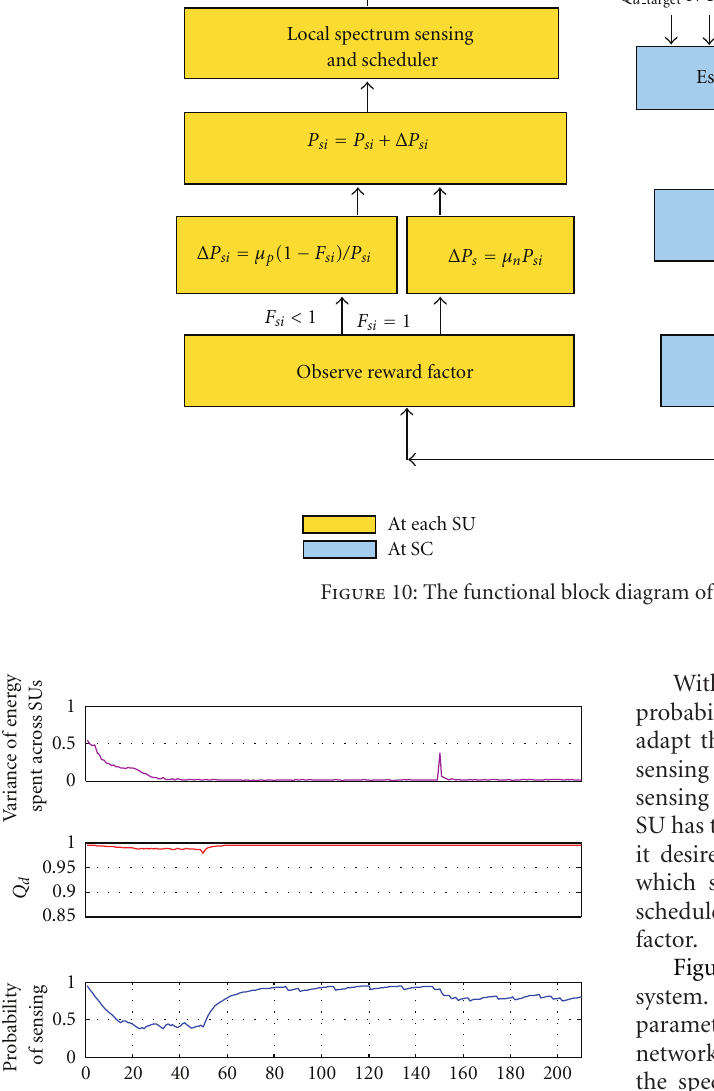
Figure 11: Behavior of the simulated system under changing environmental